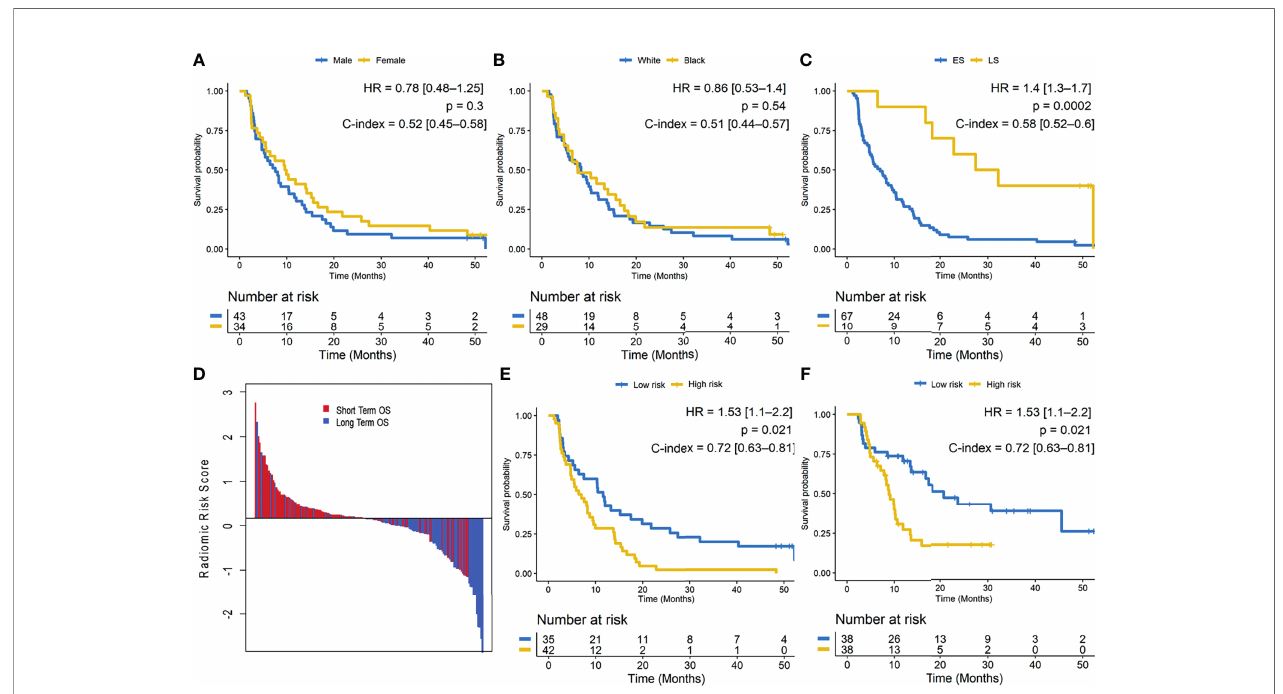
FIGURE 2 | (A – C) Kaplan – Meier survival curves for gender, race, and clinical stage on the training set. ES, extensive stage; LS, limited stage. (D) Waterfall plot of the length of overall survival (OS) based on radiomic risk score (RRS); higher risk score is associated with lower OS. (E) Kaplan – Meier survival curves based on the training set and (F) test set. A signi fi cant association of the radiomic risk score with the OS is shown in the training set and test